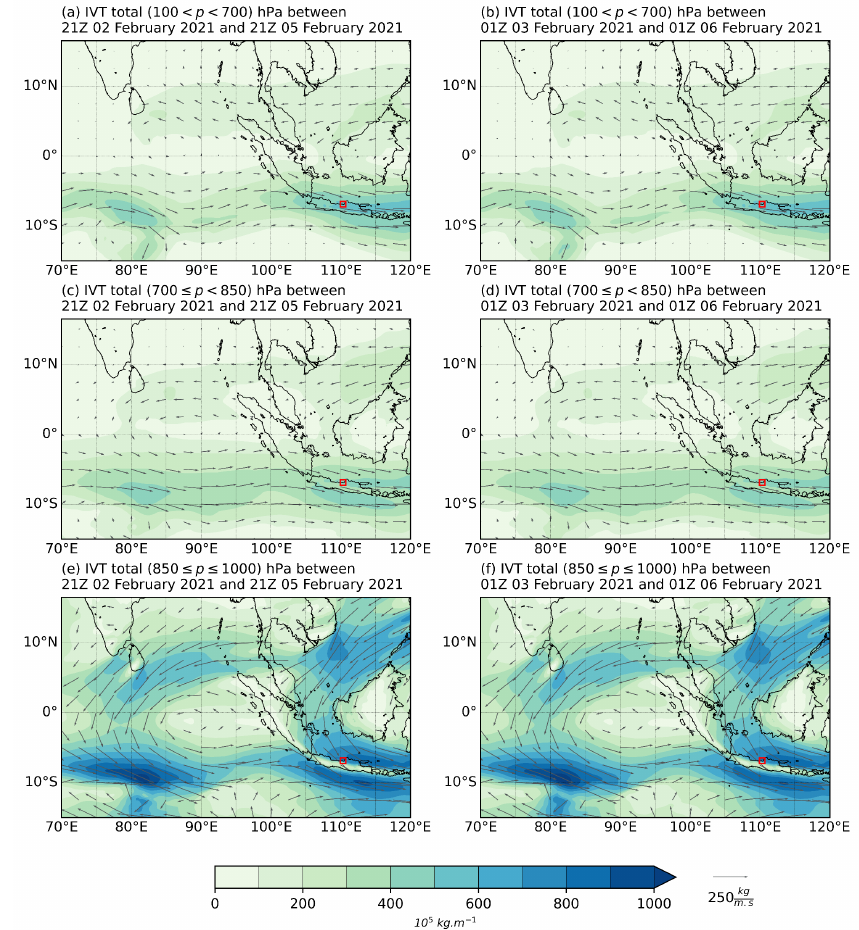
Figure 5. Time-integrated IVT for 72 h prior to the period of maximum precipitation events: ( a , c , e ) 21Z 02 to 21Z 05 February 2021 and ( b , d , f ) 00Z 03 to 00Z 06 February 2021 over three different layers: ( a , b ) (100 < p < 700) hPa, ( c , d ) (700 ≤ p < 850) hPa, and ( e , f ) (850 ≤ p ≤ 1000) hPa. The location of Semarang is denoted by a red